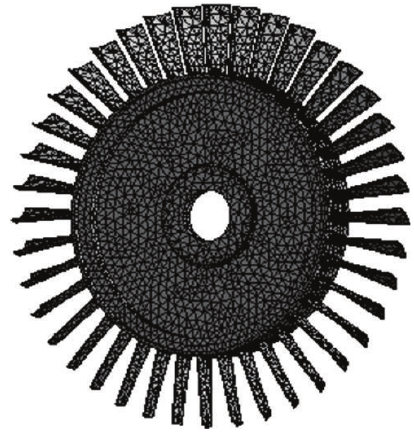
Figure 5: Grid of